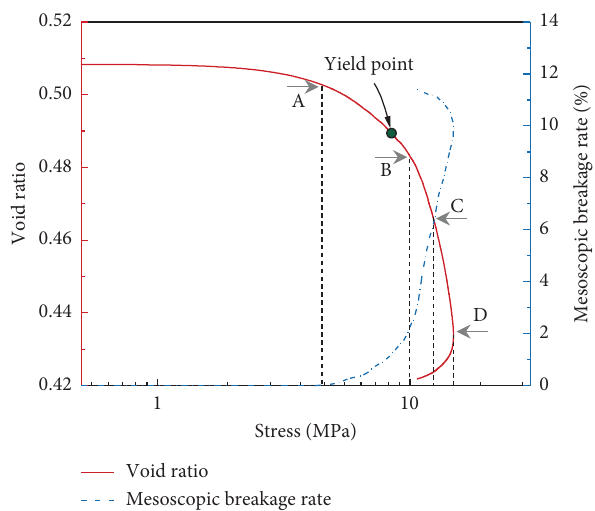
Figure 5: Te e -lg σ compression curve and the mesoscopic breakage rate development curve during the numerical dynamic confned compression test on the sand